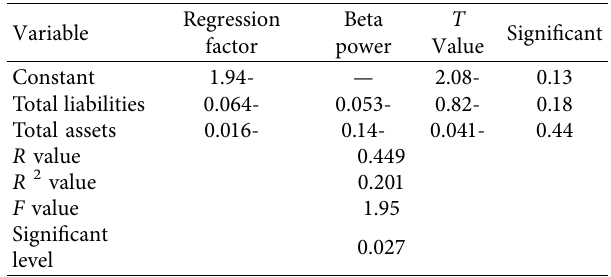
Table 12: Results of multiple linear regression analysis of the efect of list analysis on the debt-to-assets